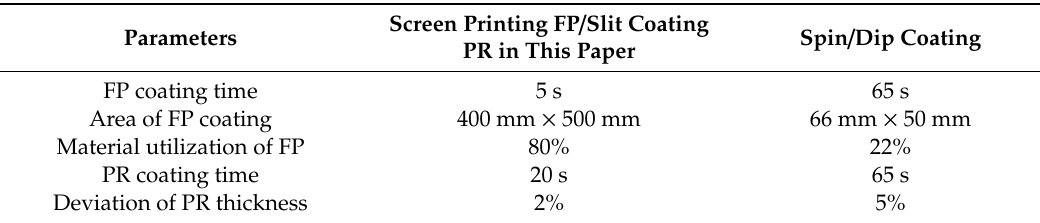
Table 2. Coating parameters of the fluoropolymer (FP) and photoresist (PR) in this paper versus spin / dip